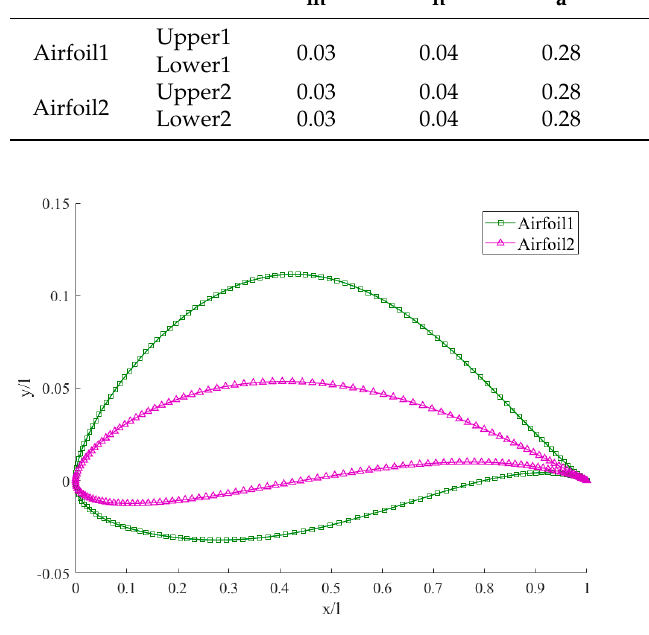
Figure 12. Geometry shape of the new airfoil. Table 2. Parameter values for generating new airfoil.